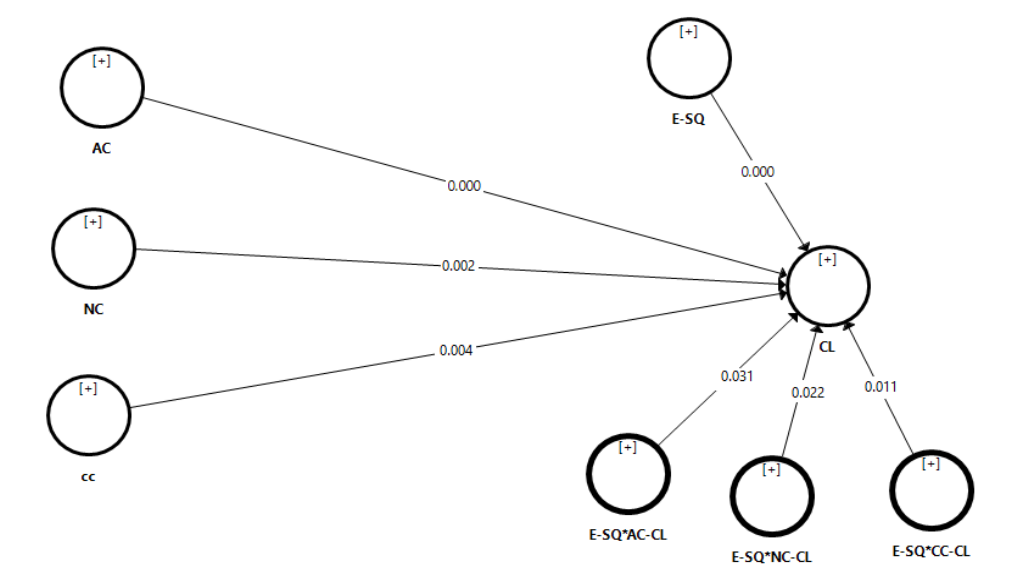
Fig. 1. The results of testing the